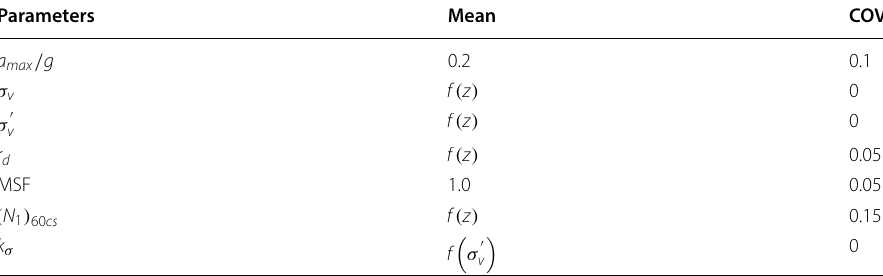
Table 7 Parameters considered for reliability analysis